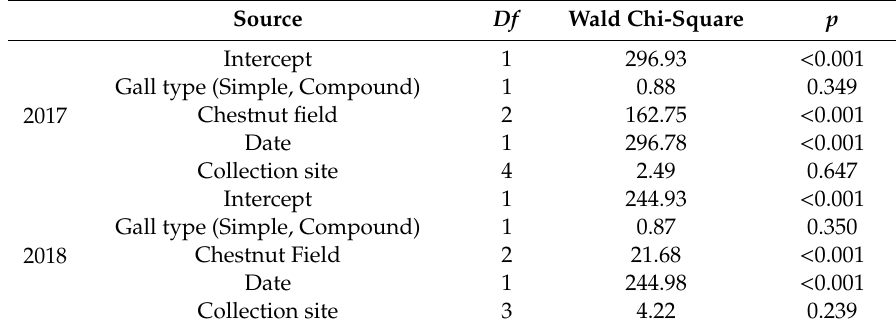
Table 2. The binomial generalized linear model (GLM)’s evaluation of the e ff ects of di ff erent variables on the parasitism rate (2017: n = 3784; 2018: n = 3053).